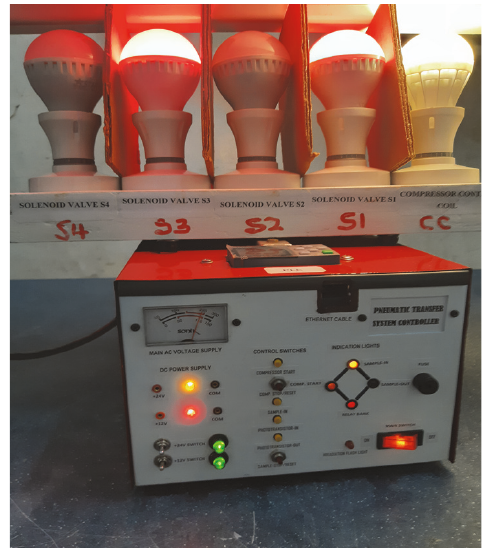
Figure 21: Irradiation cycle repeats and solenoid valves S1 and S3 open (second